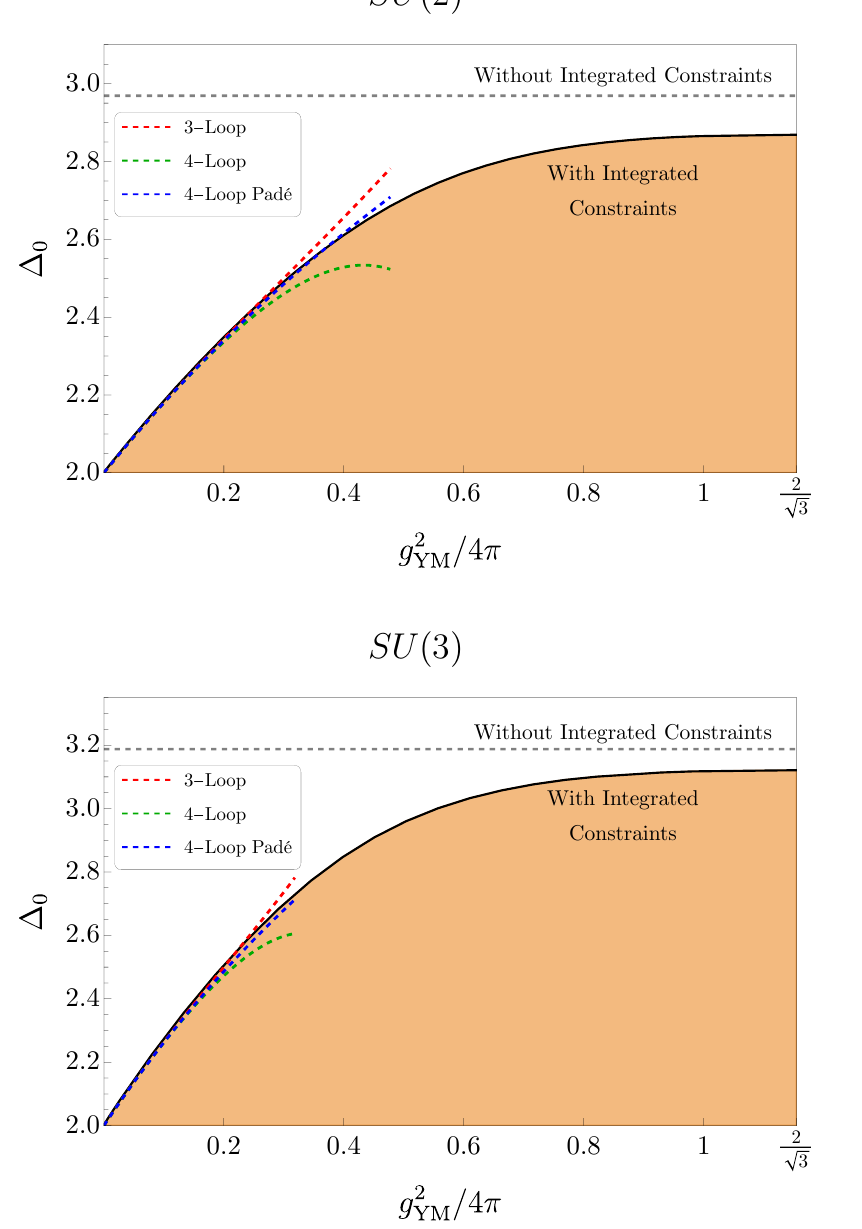
Figure 7 . Upper bounds on the scaling dimension of the lowest scalar as a function of g 2 SU (2) and SU (3) , obtained with bootstrap resolution Λ = 39 . At each value of g 2 the bottom of the fundamental domain, we give the largest upper bound that we obtain for any θ . The bounds are approximately saturated by the weak-coupling estimate (2.23) in the regime where it is valid. We also show the upper bounds that would be obtained at the same bootstrap resolution without using the integrated constraints. Note that, like the localization inputs, the slope of these upper bounds go to zero at the Z 2 self-dual point where g 2